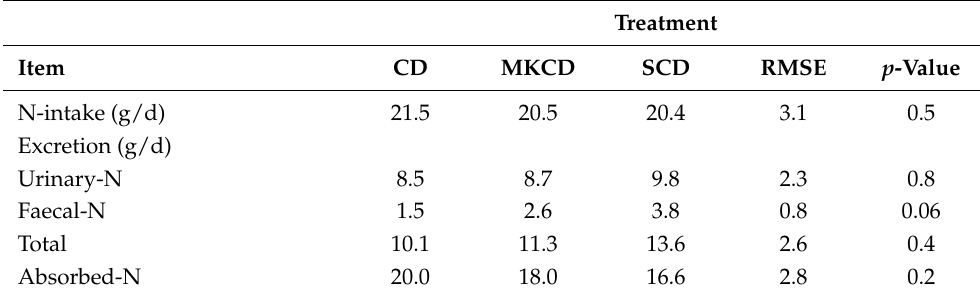
Table 5. Nitrogen balance in lambs fed different